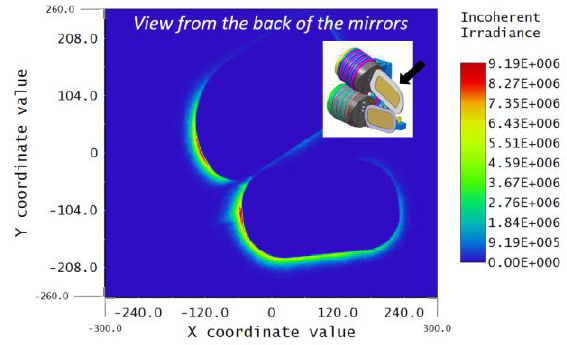
Fig. 5: Irradiance in W/m 2 of the detector placed right after the M4 mirrors to characterise the spillover considering beam deviation from